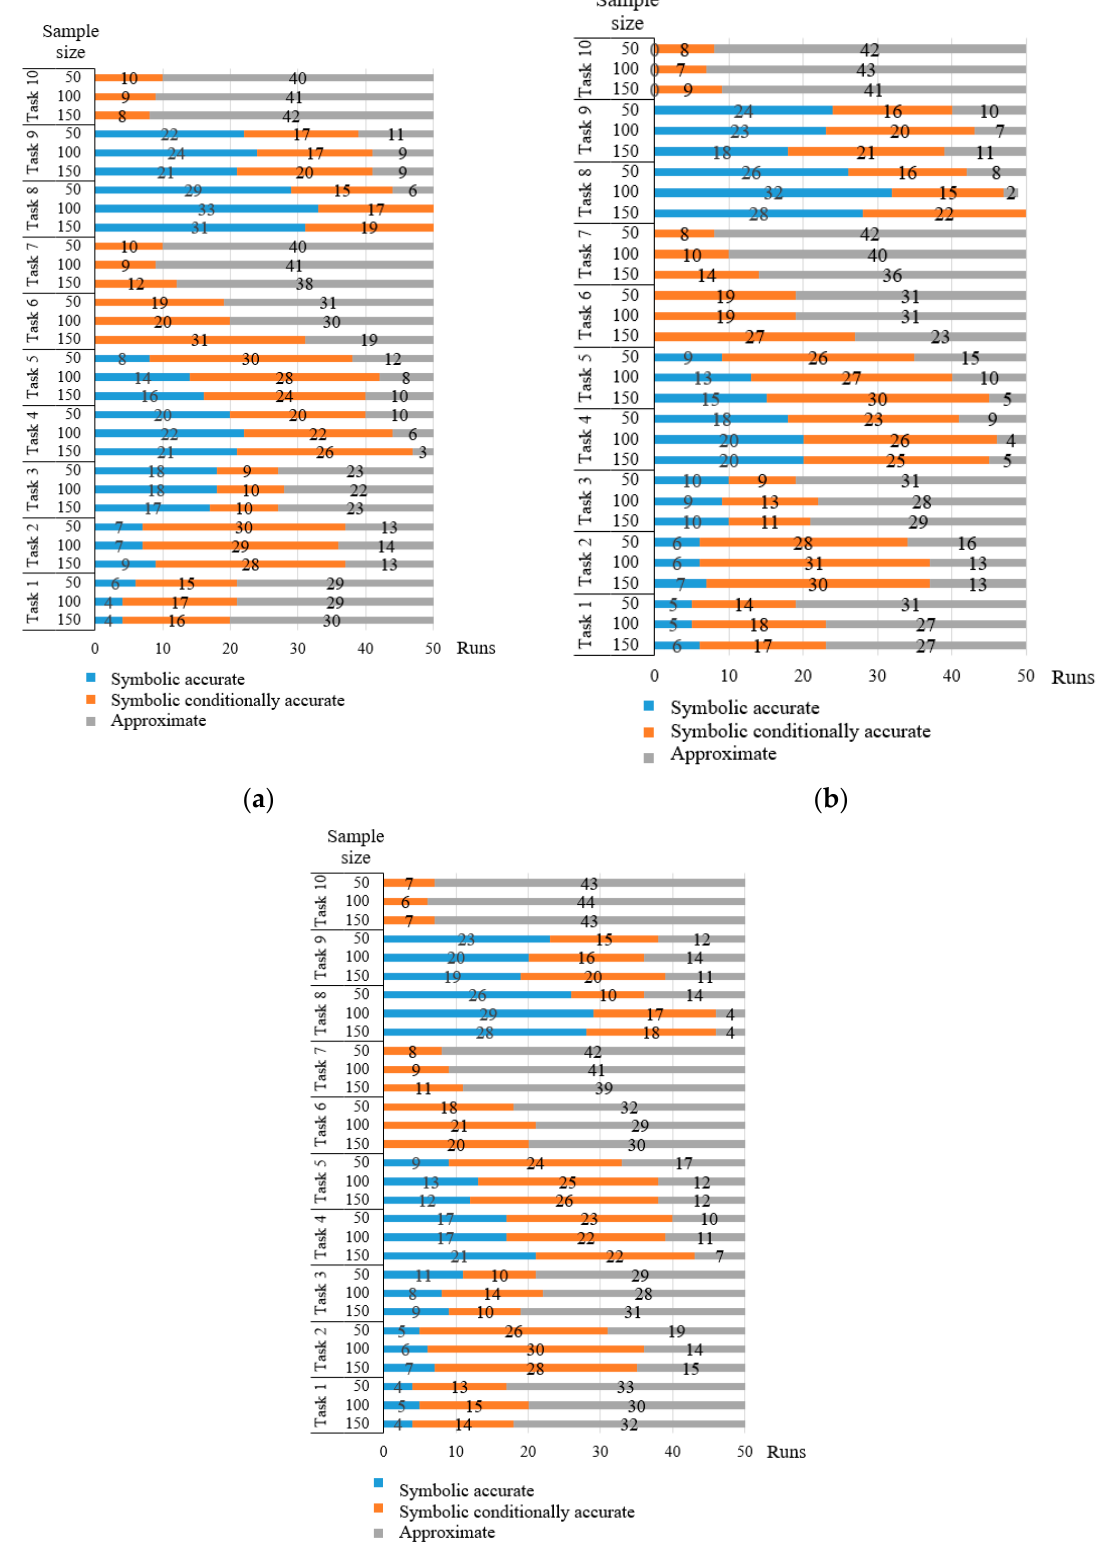
Figure 8. Symbolic accuracy of the resulting ODE systems: ( a ) Data without noise; ( b ) Data with 5% of noise; ( c ) Data with 10% of noise.